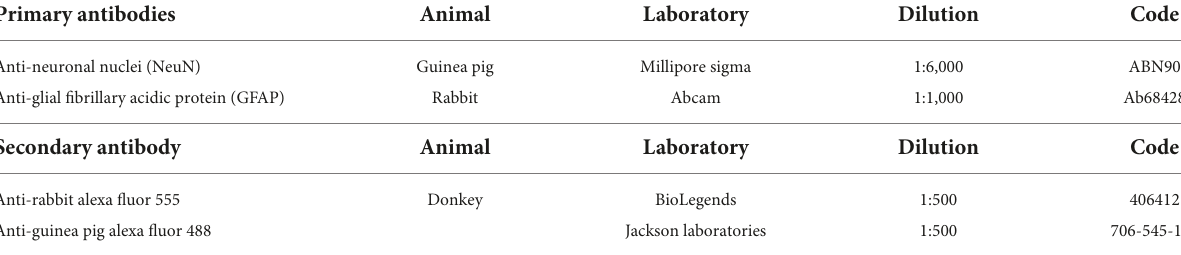
TABLE 4 Immunofluorescence